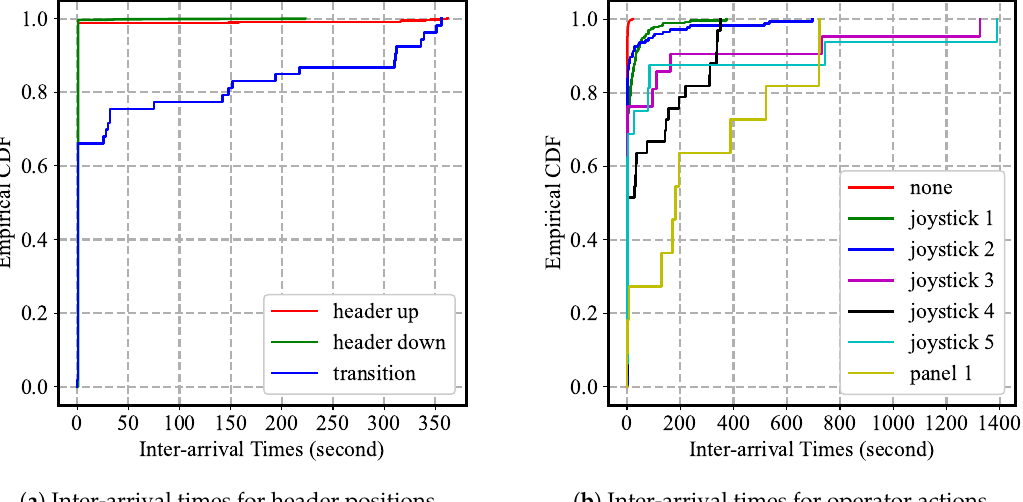
Figure 16. The empirical CDFs were estimated for the inter-arrival times for both sets of labels. Domain knowledge can be applied to explain the maximum of the inter-arrival times and the smoothness of the